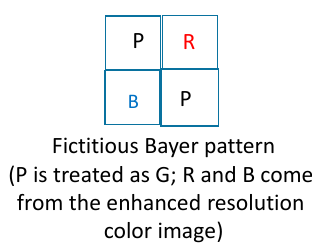
Figure 7. Fictitious Bayer pattern when there is feedback.